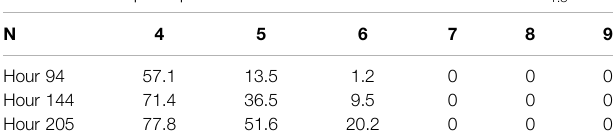
TABLE 3| Fromthenine-spacecraftcon fi gurationsofhours94,144,and205,we selectasubsetof N ∈ {4,5,6,7,8,9}spacecraft.Wedeterminetheprobability that this N spacecraft con fi guration does not contain a tetrahedron which passes the threshold shape requirements of fi rst-order reconstruction method M 1.3